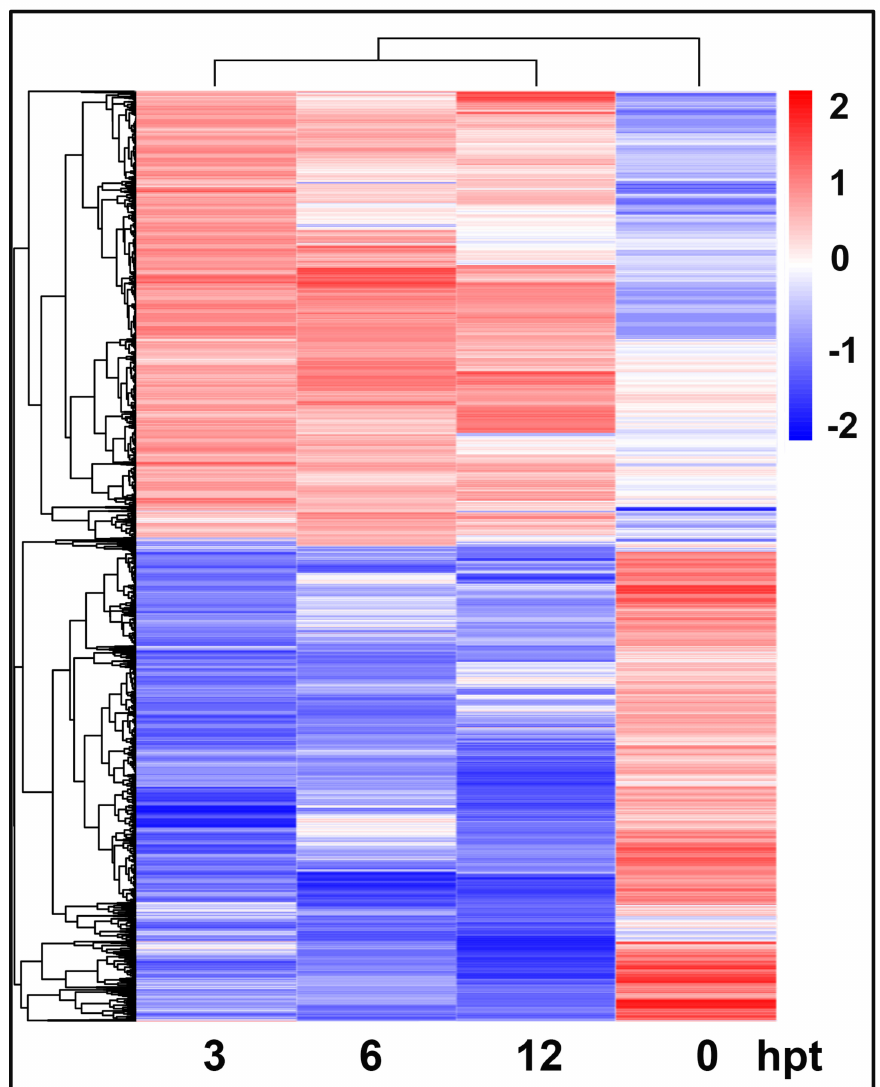
Figure 3. Heat map and dendrograms of hierarchical clustering showing the expression patterns of all DEGs in response to SCR96 treatment at four time-points (0, 3, 6, 12 hpt). The colors represent the upregulation (red) and downregulation (blue) of statistically significant DEGs (log2|fold change| > 1, p < 0.01) with different magnitudes (brightness) for the log2 fold change values. The dendrogram on top shows the clustering of time points. The dendrogram on left side shows the clustering of